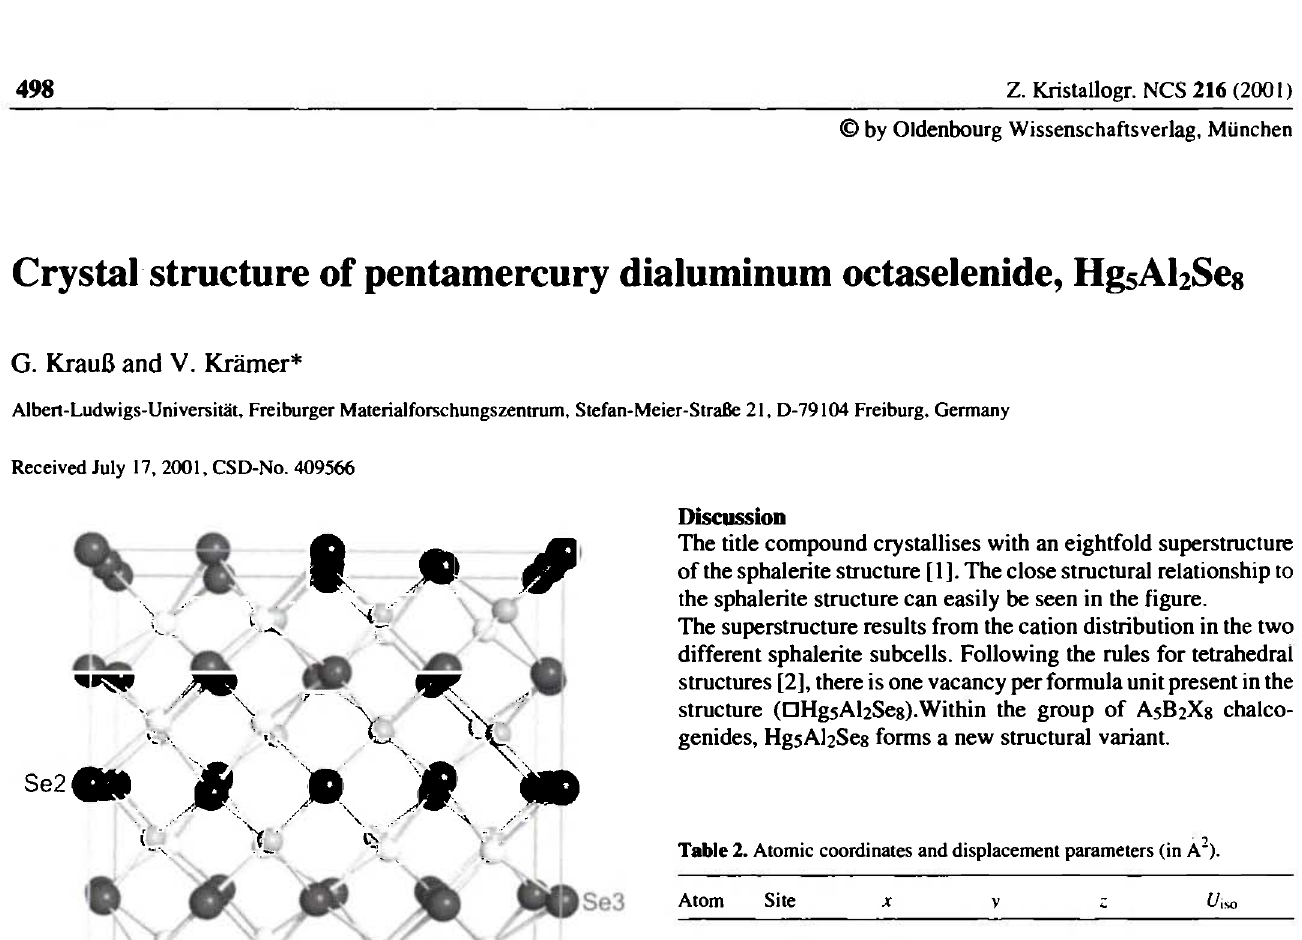
AhHgsSes, cubic, F43m (No. 216), a = 11.704(1) Ä, V = 1603.3 Ä 3 , Z = 4, R(P) = 0.070, wR(P) = 0.093, R(I)= 0.122,7-= 293 K.